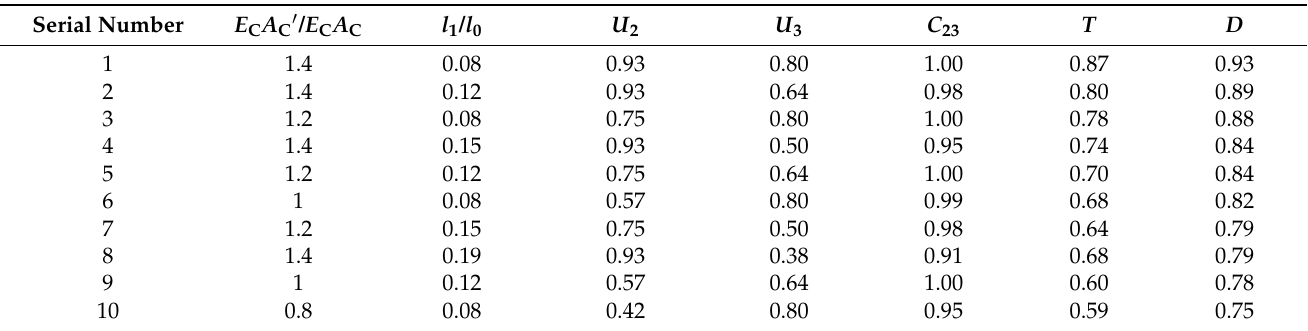
Table 9. Calculation results of coupling coordination between slant cable stiffness and uncoupled area in the span.